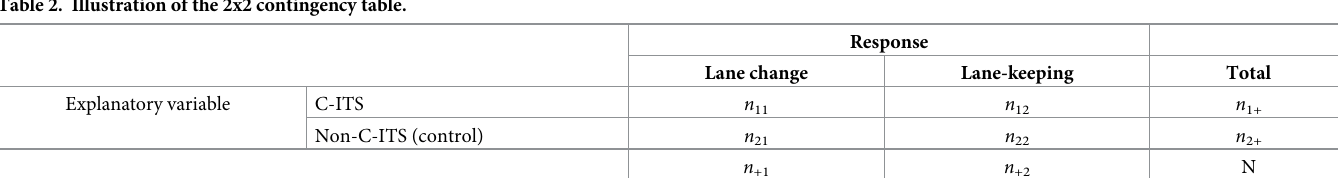
Table 2. Illustration of the 2x2 contingency